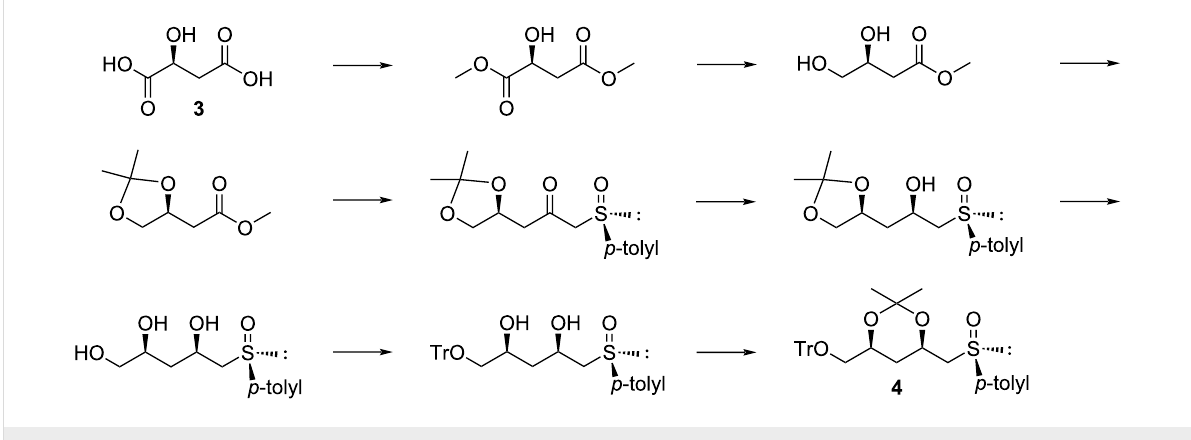
Scheme 1: Established route for the synthesis of intermediate 4 [1].